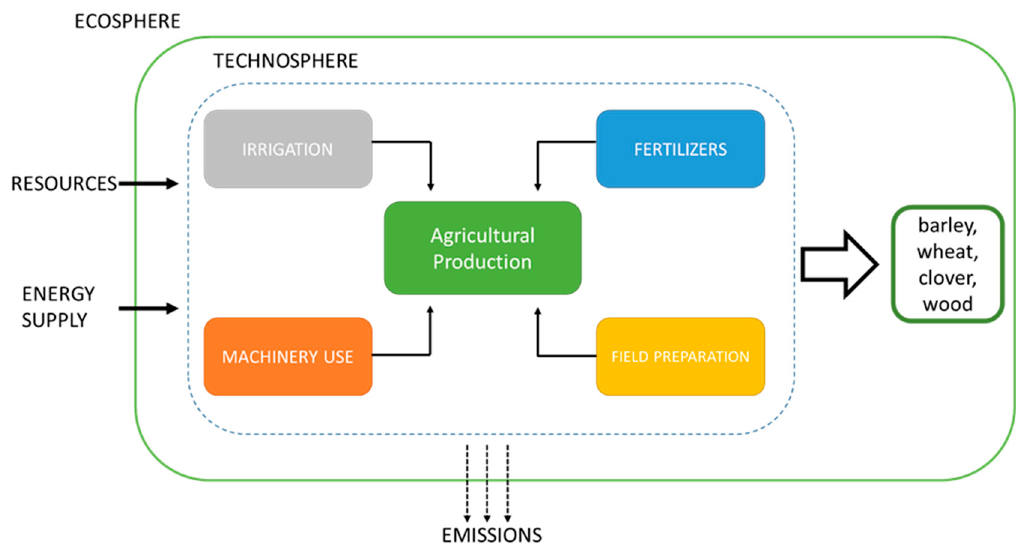
Figure 2. General flow diagram for the combined food and energy production system in Denmark.